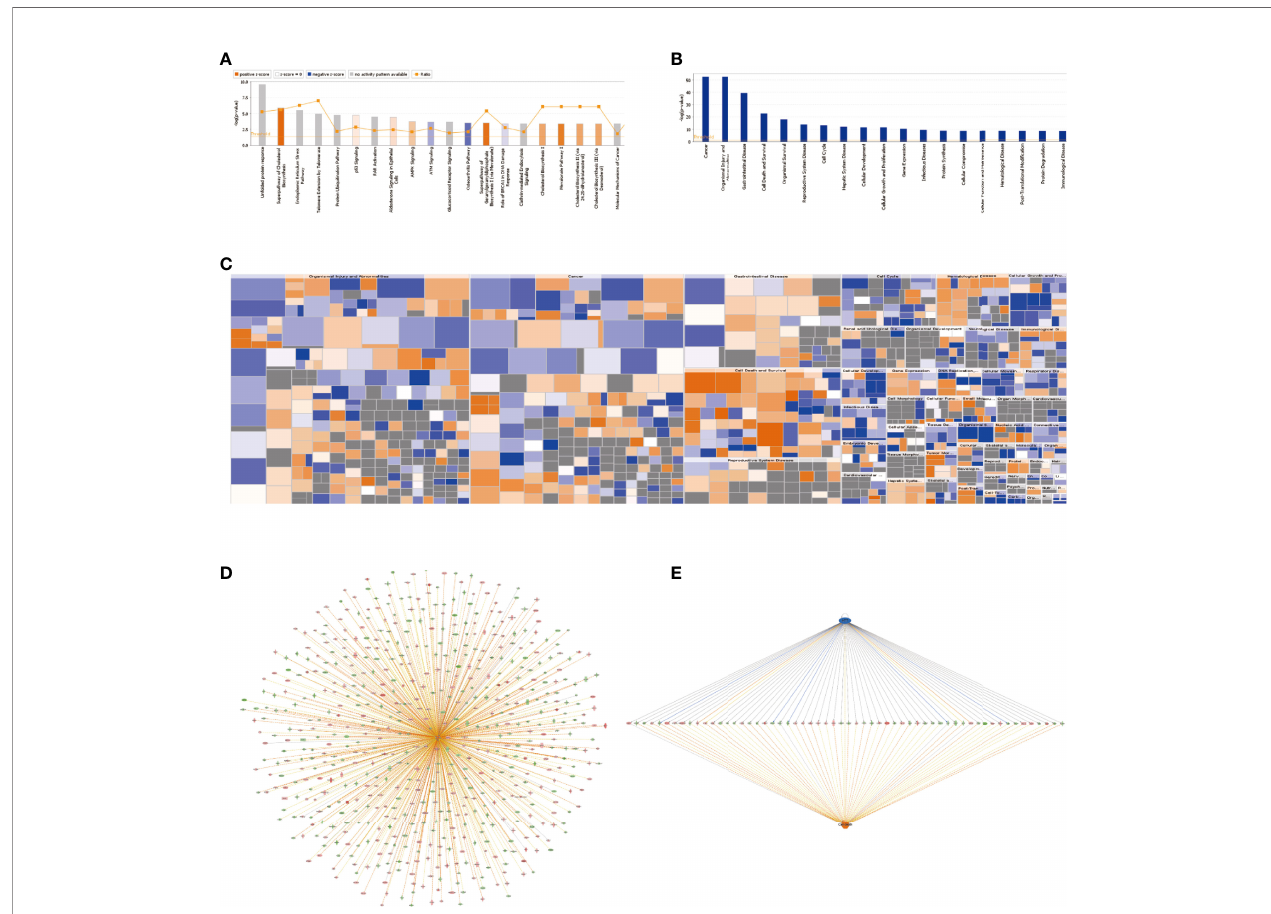
FIGURE 2 | Expression pro fi ling using Affymetrix GeneChip microarrays to analyze the genes with signi fi cantly different expression after knocking down SMPDL3A (A) Classic pathway analysis showed the signi fi cant enrichment of DEGs in the classic pathways. (B) The signi fi cant enrichment of DEGs in diseases and functions. The abscissa is the name of pathway, and the ordinate represents the degree of enrichment (logarithmic transformation at the base of 10) . (C) The “ Diseases and functions ” heatmap shows the activation/inhibition relationship of the changes in DEG expression on disease and function. Orange stands for activation (Z-score>0), blue for inhibition (Z-score<0), grey indicates not determined (Z-score unable to calculate). (D) Genetic disease and functional network diagram based on “ Cell death ” . Orange line indicates lead to activation, blue line indicates leads to inhibition, yellow lines indicate fi ndings inconsistent with the state of molecules and gray lines indicate unknown. (E) The possible upstream regulatory networks and downstream functions of the DEGs.